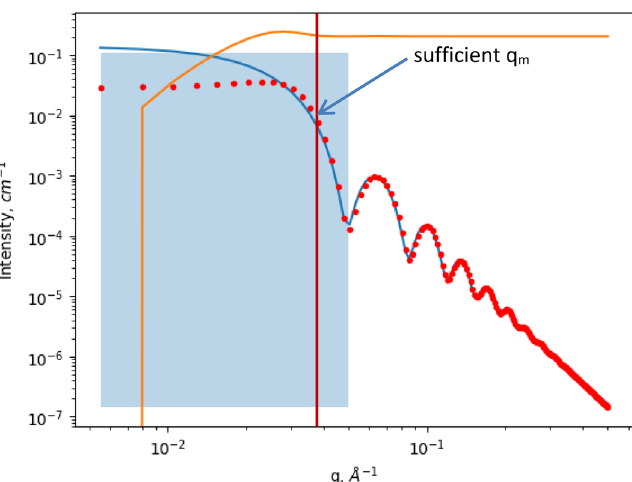
Figure 2. Simulated scattering curve of polystyrene in water (red dots); best fit (blue line); invariant calculation range, with the right side equal to q m (blue rectangle); cumulative invariant calculation (orange line) multiplied by the factor of 10 –18 to make its scale closer to the scattering curves.